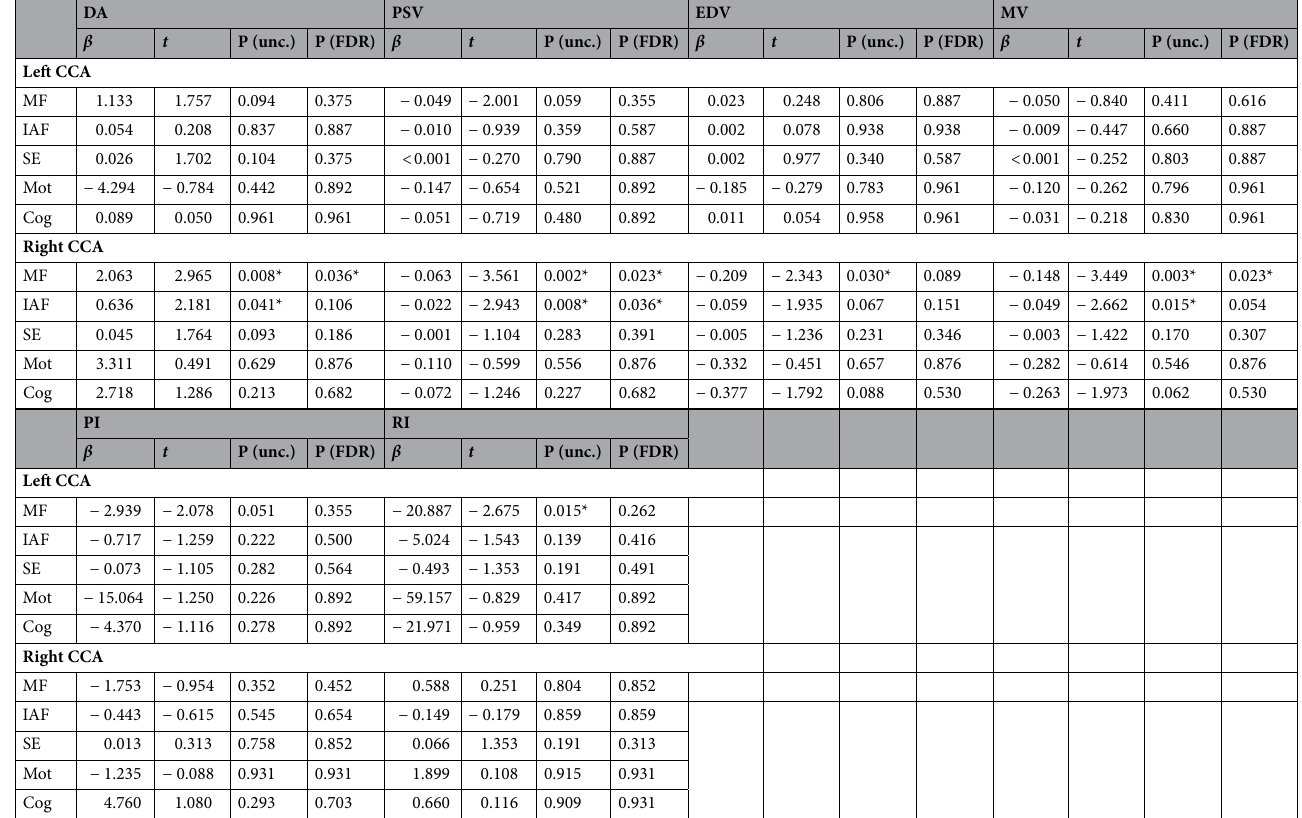
Table 3. Results of LMEM examining the effects of the left ultrasonographic parameters on MEG spectral parameters and FIM. CCA common carotid arteries, Cog . cognitive-FIM score, FIM functional independent measurement, IAF individual alpha frequency, LMEM linear mixed-effect model, MEG magnetoencephalography, MF median frequency, Mot . motor-FIM score, P (FDR) p values of bootstrapping statistics with FDR-correction, P (unc.) uncorrected p values of t test, SE Shannon entropy. β , estimated coefficient of the predictor. t , t -values for testing the null hypothesis that the coefficients are equal to zero. *The terms that make significant contributions to the